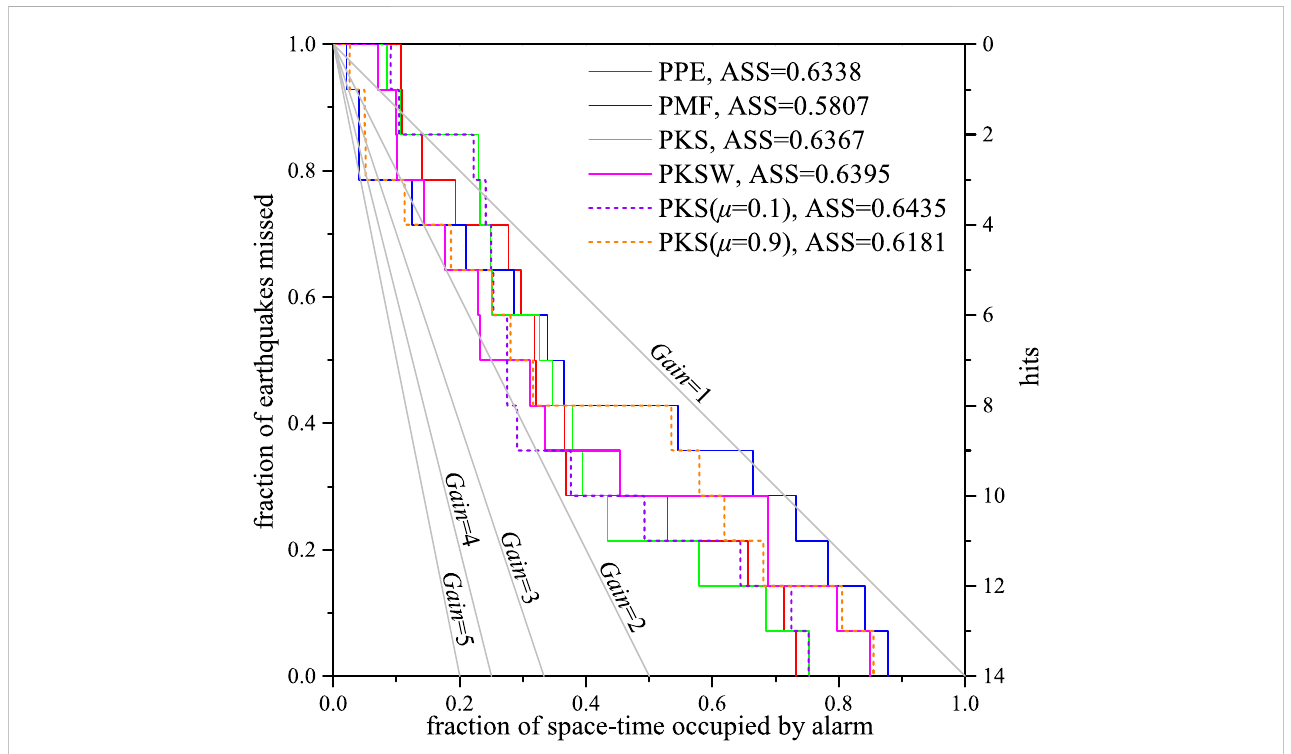
FIGURE 6 Molchan error diagram for the PPE (red curves), proximity-to-mapped-faults (PMF) (blue curves), and proximity-to-known-sources (PKS) models with different weighting schemes (green curves: μ value optimized by maximizing the likelihood function, pink curves: μ value calculated using Eq. 4; short purple and orange dashed curves: μ values manually speci fi ed at 0.1 and 0.9) at three different times: May 20, 2008; January 1, 2013; and September 10, 2019. The area skill score (ASS); that is, the area above the error diagram inside the unit square, is used to evaluate the ef fi ciency of the earthquake